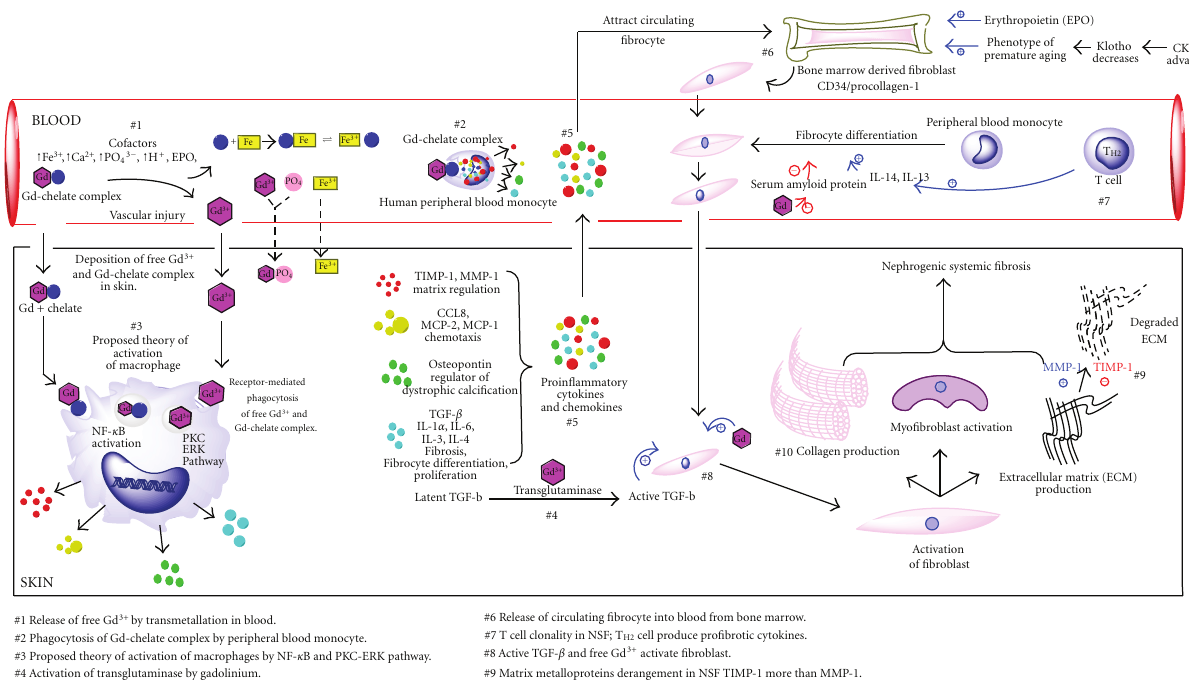
Figure 1: Schematic representation of the proposed pathophysiology of